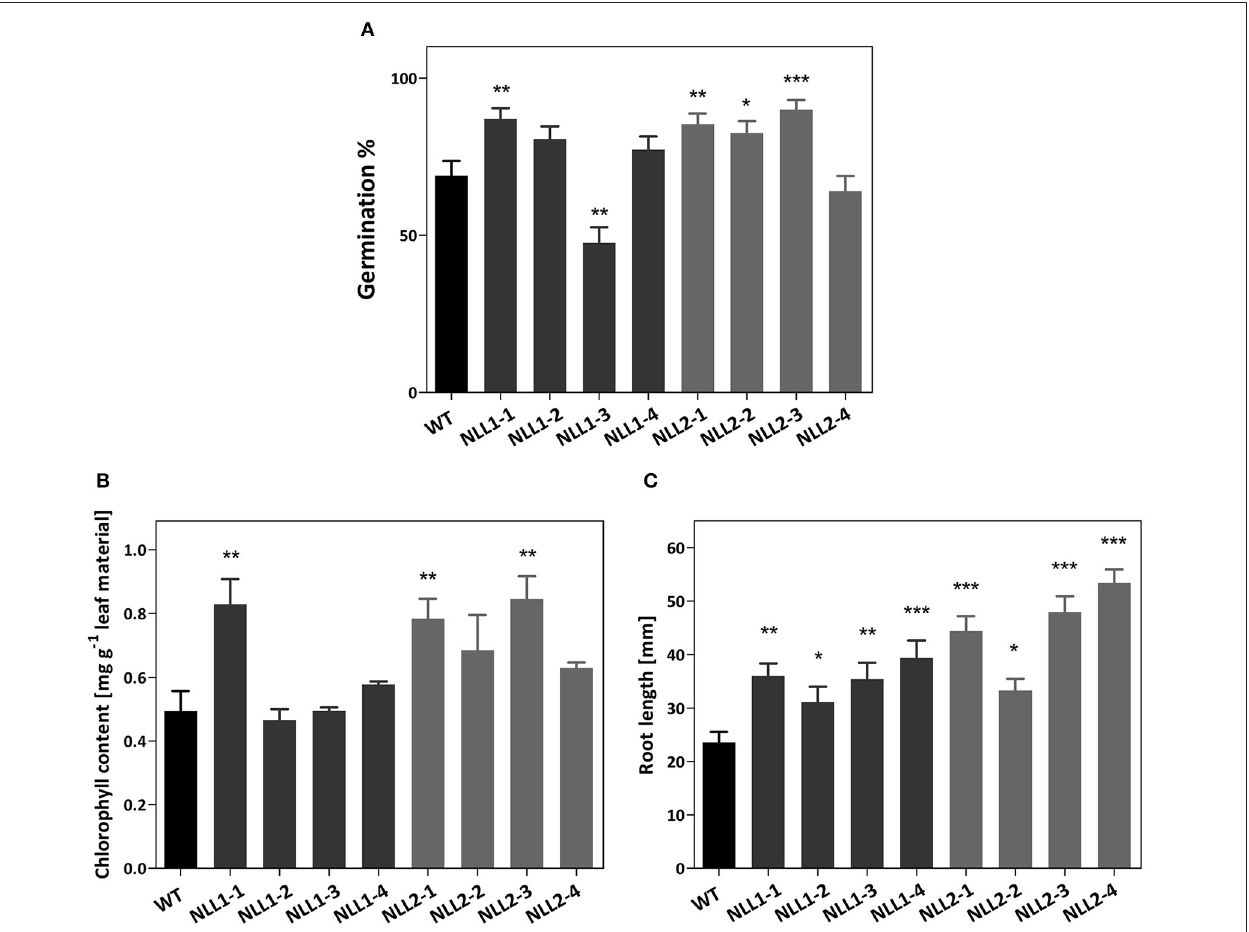
FIGURE 7 | (A) Effect of GmNLL1 and GmNLL2 overexpression on Arabidopsis germination on ½ MS supplemented with 150 mM NaCl. Germination percentage determined on day 6, result from two biological replicates with 50 seeds per replicate, germination percentages with the corresponding standard errors are shown. (B) Total chlorophyll content (chlorophyll a + b ) of GmNLL1 and GmNLL2 transgenic lines and wild type plants 7 days after transfer to ½ MS supplemented with 150 mM NaCl. Data shows the mean ± SE of two biological replicates. (C) Root length of 14-day-old GmNLL1 and GmNLL2 transgenic lines and wild type plants grown on ½ MS supplemented with 150 mM NaCl. Data shows the mean ± SE of two biological replicates with at least 30 measurements in each replicate. Asterisks indicate statistically significant differences compared to wild type (* p < 0.05, ** p < 0.01, *** p <